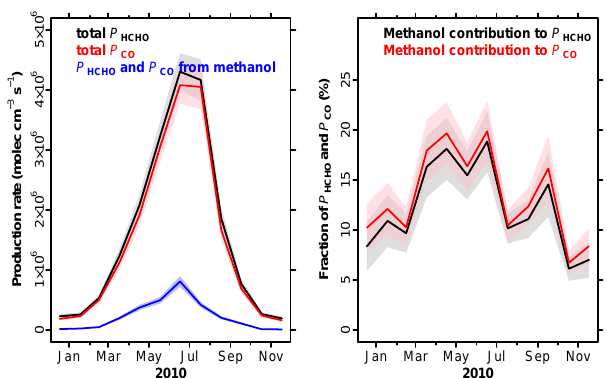
Monthly mean methanol contribution to the production rates of HCHO and CO at the KCMP tall tower, estimated as de- scribed in the text. Left panel: monthly mean production rates of HCHO and CO calculated from observed methanol concentrations at the KCMP tall tower (blue) compared to the total production rates of HCHO (black) and CO (red) simulated by GEOS-Chem. Right panel: monthly CO and HCHO production rates computed from the methanol measurements at the KCMP tall tower plotted as a frac- tion of the total production rates simulated by GEOS-Chem. Shaded areas show the 95% confidence